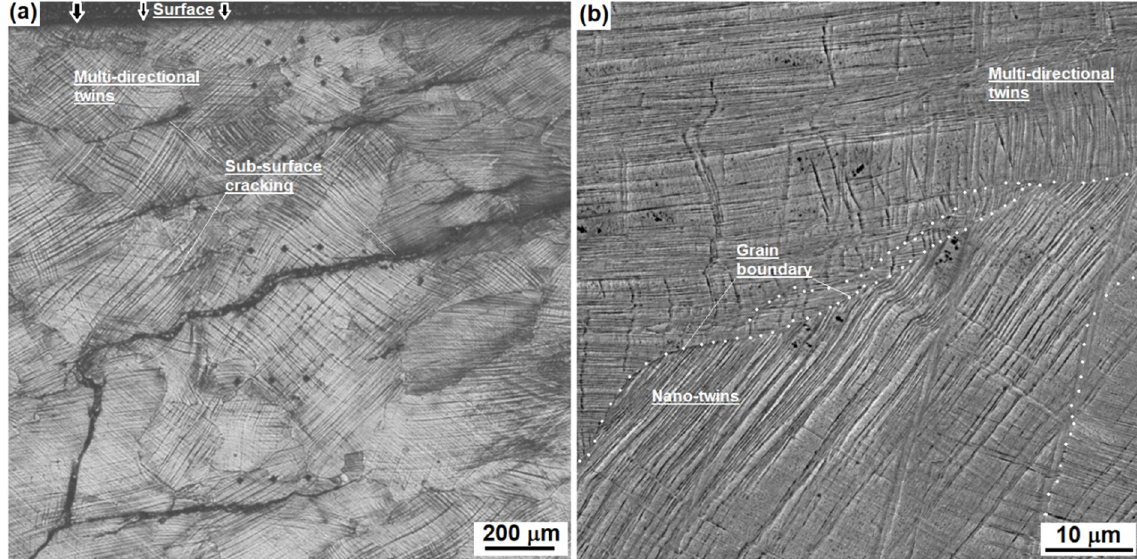
Figure 11. Cross-sectional microstructure of the worn Hadfield steel turnout: ( a ) an optical image showing deformation bands and cracks from the rail top at a certain depth; and ( b ) a SEM image showing different orientations of mechanical twins beside a grain boundary.